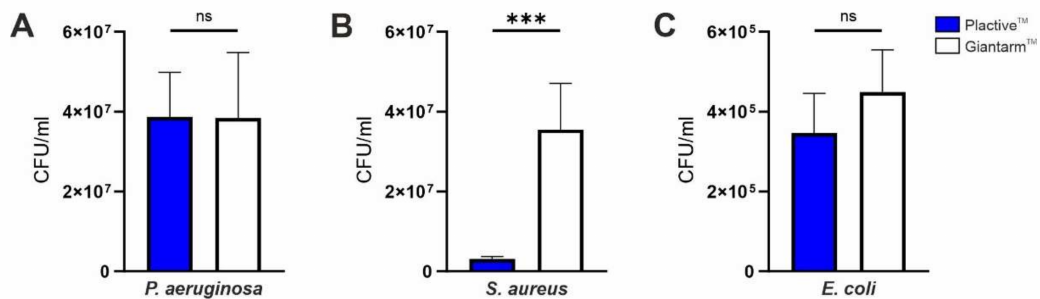
Figure 6. Colony forming unit (CFU) assays of P. aeruginosa , S. aureus, and E. coli . ( A ) CFU assay revealing the number of CFUs per ml ( y -axis) for the growth of P. aeruginosa on Plactive™ PLA (blue) and Giantarm™ PLA (white). ( B ) CFU assay revealing the number of CFUs per ml ( y -axis) for the growth of S. aureus on Plactive™ PLA (blue) and Giantarm™ PLA (white). ( C ) CFU assay revealing the number of CFUs per ml ( y -axis) for the growth of E. coli on Plactive™ PLA (blue) and Giantarm™ PLA